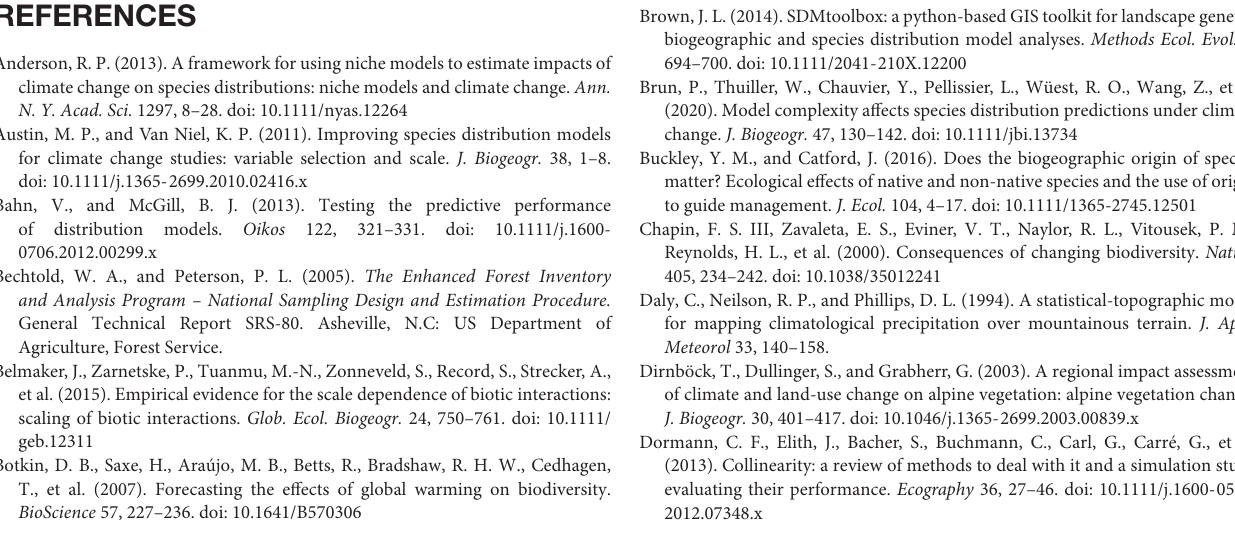
Supplementary Figure 1 | Correlations between bioclimatic variables.